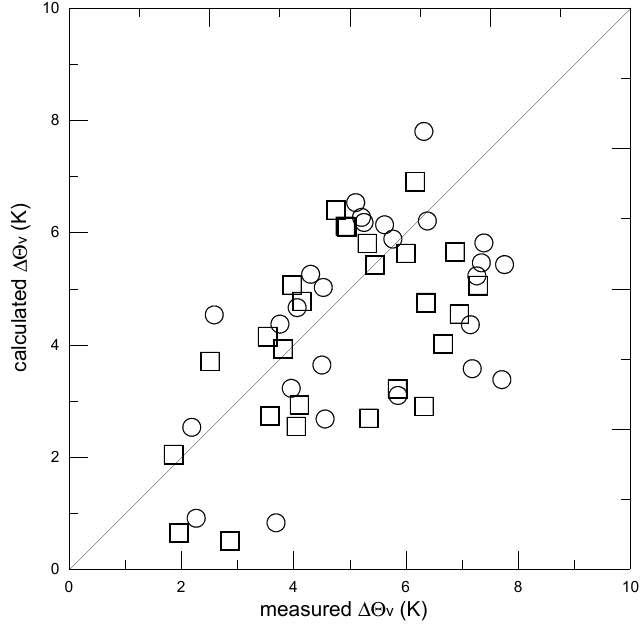
Figure 6. Test for ΔΘ v obtained by the PM model with the calibrated parameters versus the measured values (squares: Level 3, circles: Level